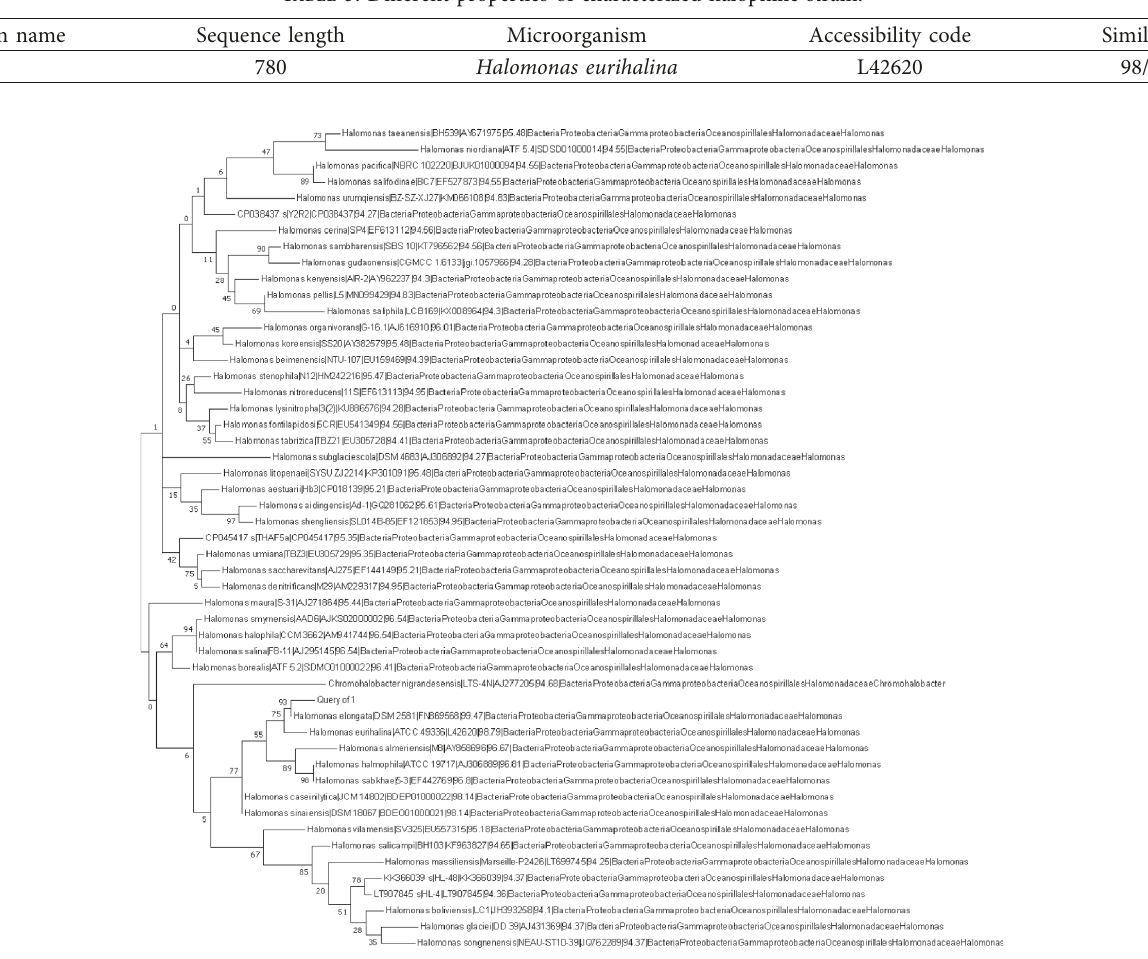
Figure 1: Phylogenic tree conducted by MEGA7. Query 1 represented the isolated strain that is the most similar to Halomonas eurihalina .